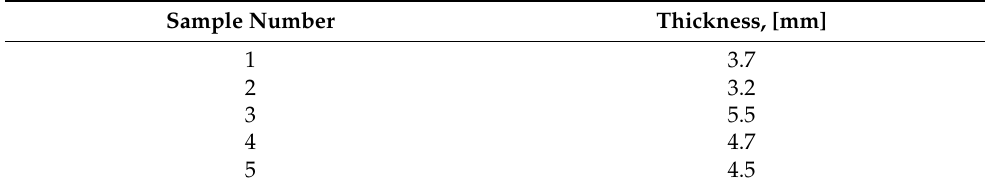
Table 2. Measurement results of worker bee body homogenate